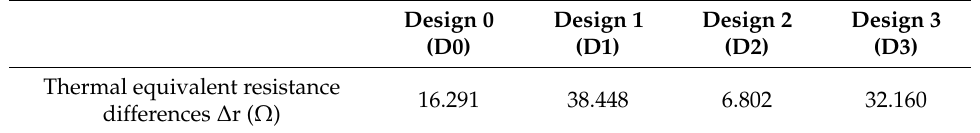
Table 4. Thermal equivalent resistance differences (TERD, i.e., ∆ r) of 4 proposed microbolometer